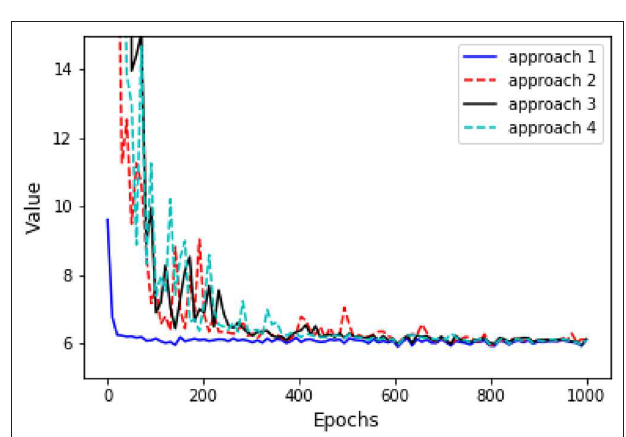
FIGURE 8 | Comparison convergence of objective values as in (3.10) among four